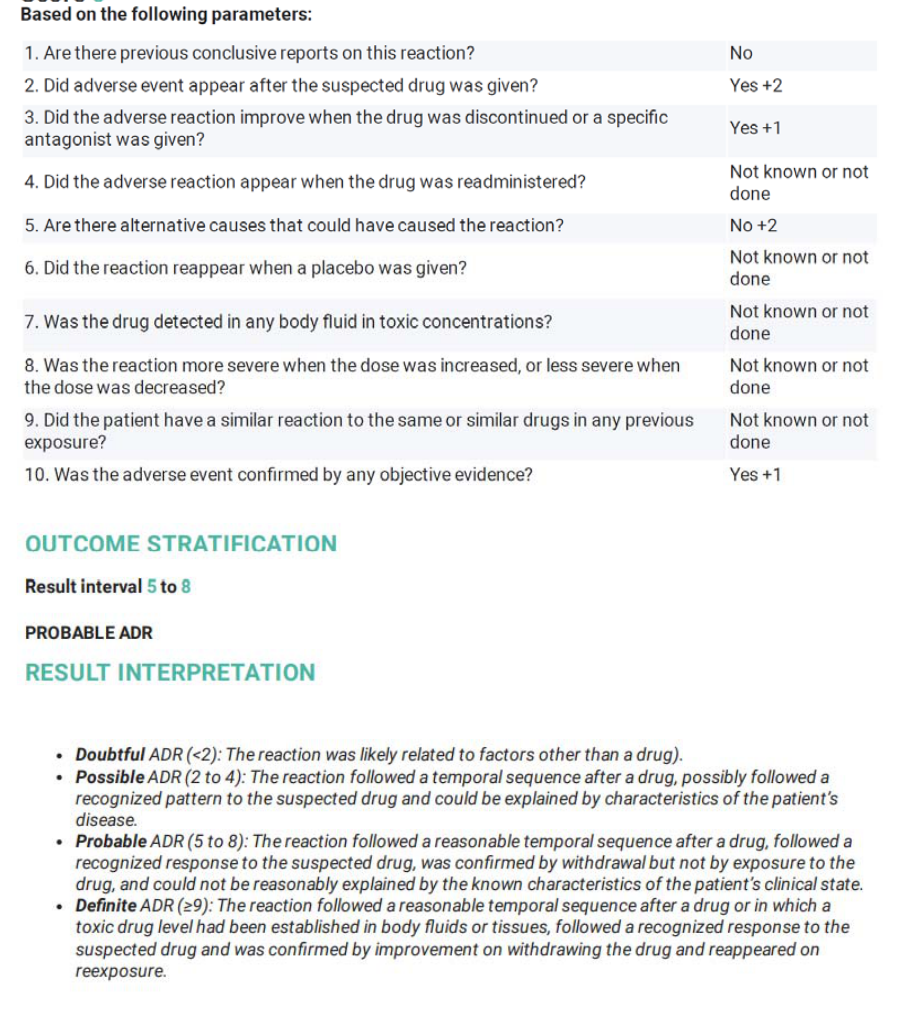
Figure 5. Naranjo Adverse Drug Reaction Probability Scale (Taken and adapted from www.evidencio.com/models/show/661, accessed on 8 March 2022).